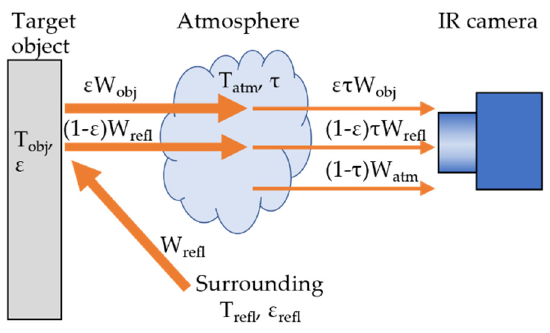
Figure 1. Diagram of temperature measurement by infrared (IR) camera.